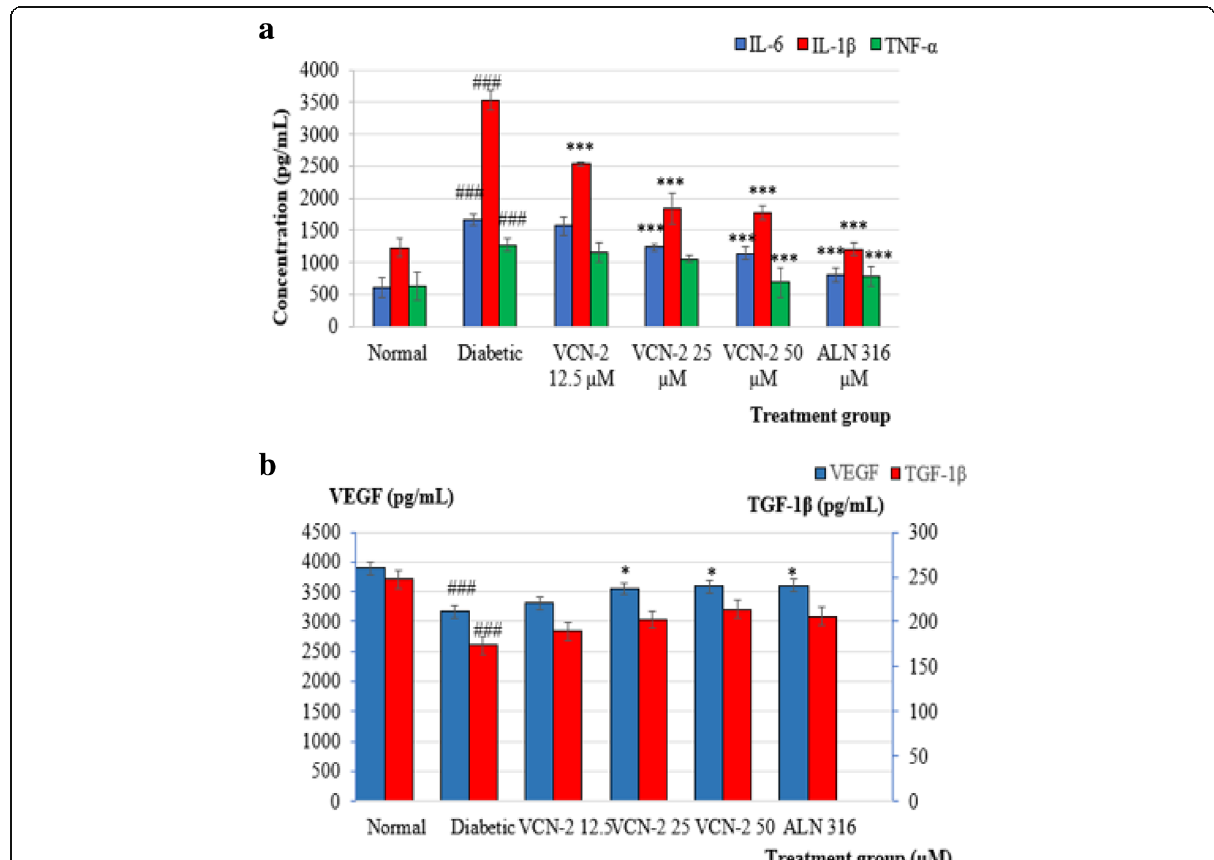
Fig. 5 a Effect of VCN-2 hydrocolloid film which was topically applied on normal and diabetic rats inflicted with excision wound for 14 days. Production of pro-inflammatory cytokines such as IL-1 β , IL-6 and TNF- α after different concentration of VCN-2 treatments. b Secretions of growth factors like VEGF and TGF-1 β on day 14 with treatment of VCN-2 in concentration 12.5, 25, 50 μ M. All values are expressed as mean ± SEM. Each group consists of six rats. ### p < 0.001, diabetic group compared to normal group; *** p < 0.001, treatments groups compared to diabetic